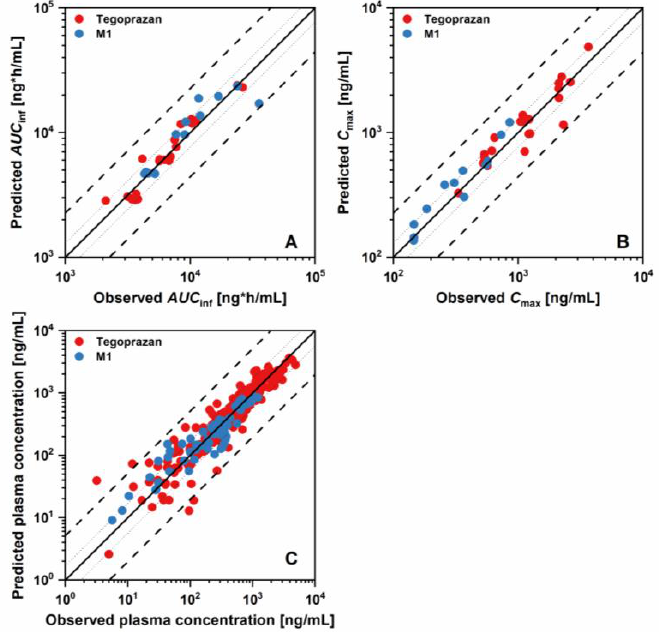
Figure 3. Goodness-of-fit plots for the developed PBPK model of tegoprazan for the prediction of ( A ) plasma concentration, ( B ) Cmax, and ( C ) AUC inf. The line of identity is presented as a solid line; 1.25-fold dimensions and 2.0-fold dimensions are shown using dotted lines and dashed lines, respectively.